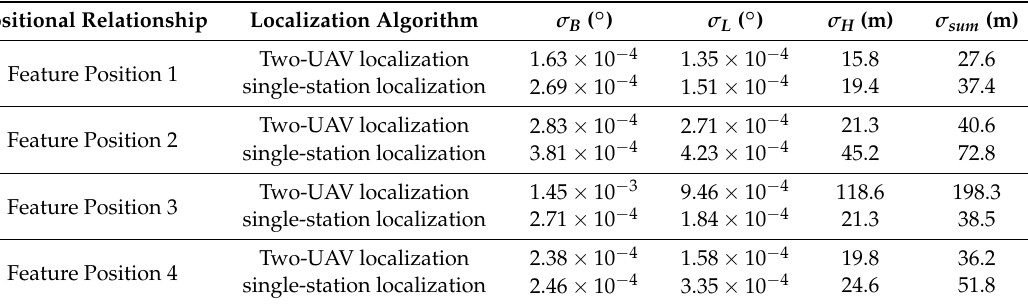
Table 2. Localization error.